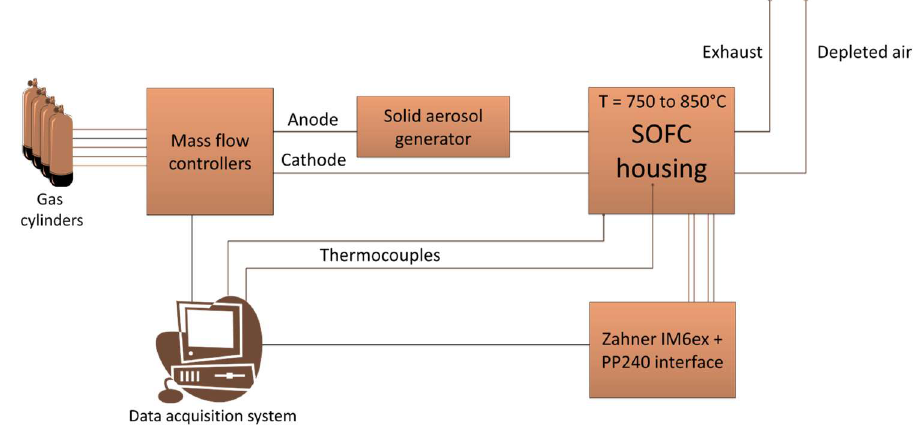
Figure 2. Chart of the test setup used to investigate SOFC with aerosol-contaminated fuel, based on [36].